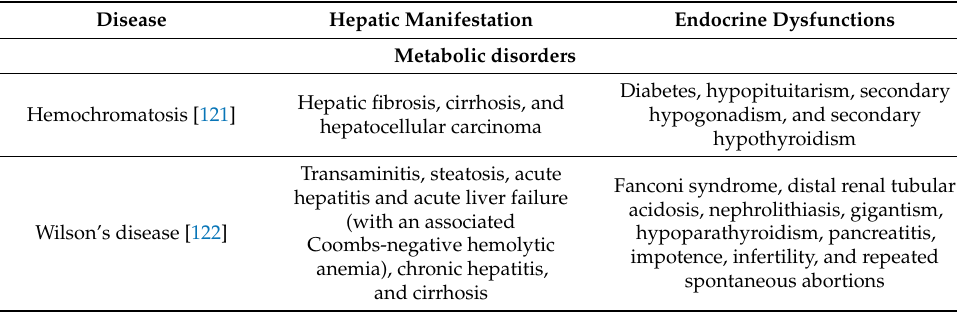
Table 4. Hepato-endocrine